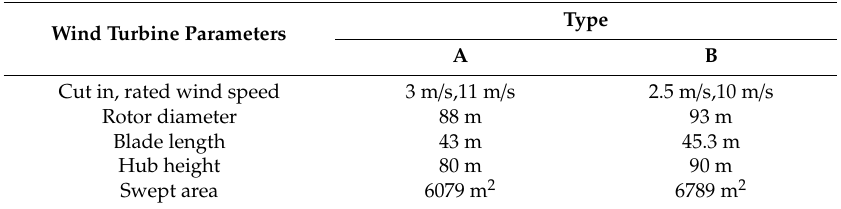
Table 1. Specification of two types of wind turbines.